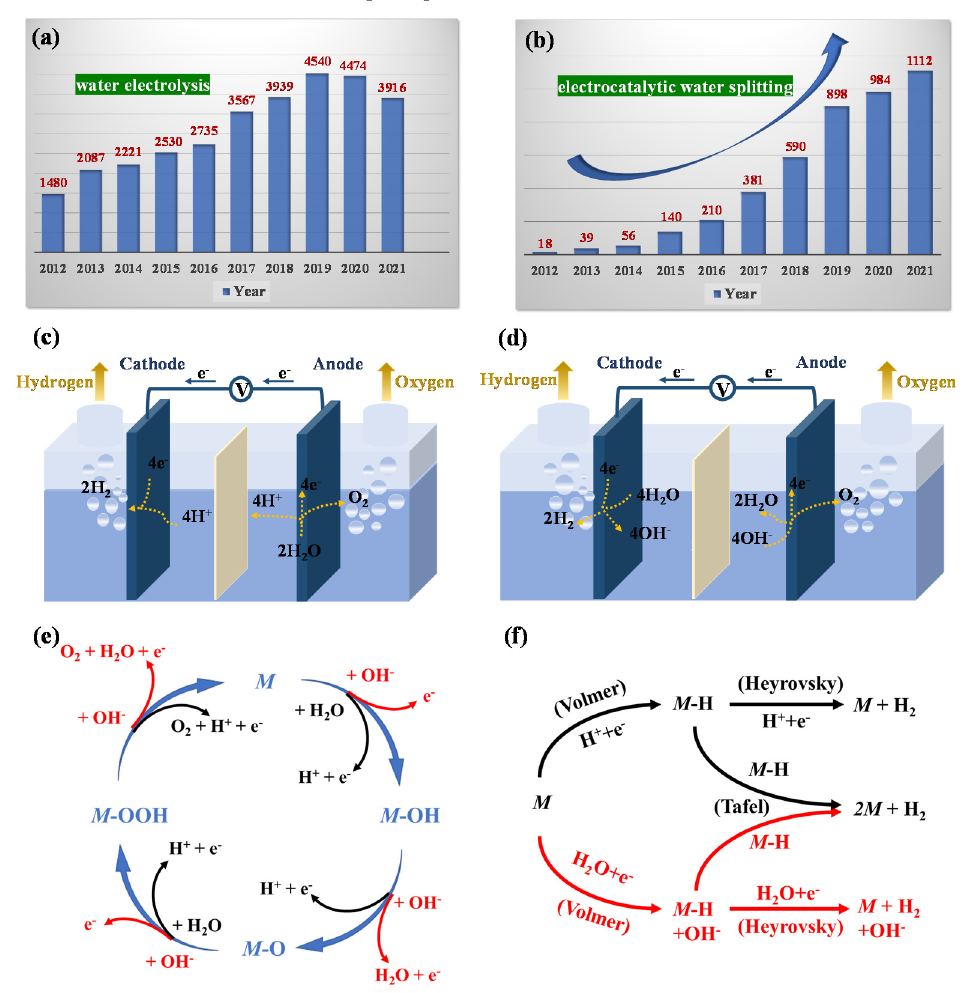
Figure 1. Roughly estimated numbers of publications during 2012–2021 from Web of Science, which were obtained by searching the following keywords: ( a ) “water electrolysis” and ( b ) “electrocatalytic water splitting”. Schematic illustration of an archetypal electrolysis cell for water splitting under ( c ) acidic conditions and ( d ) alkaline solutions. ( e ) The OER mechanism for acid (black line) and alkaline (red line) conditions. ( f ) The HER mechanism for acid (black line) and alkaline (red line) conditions.